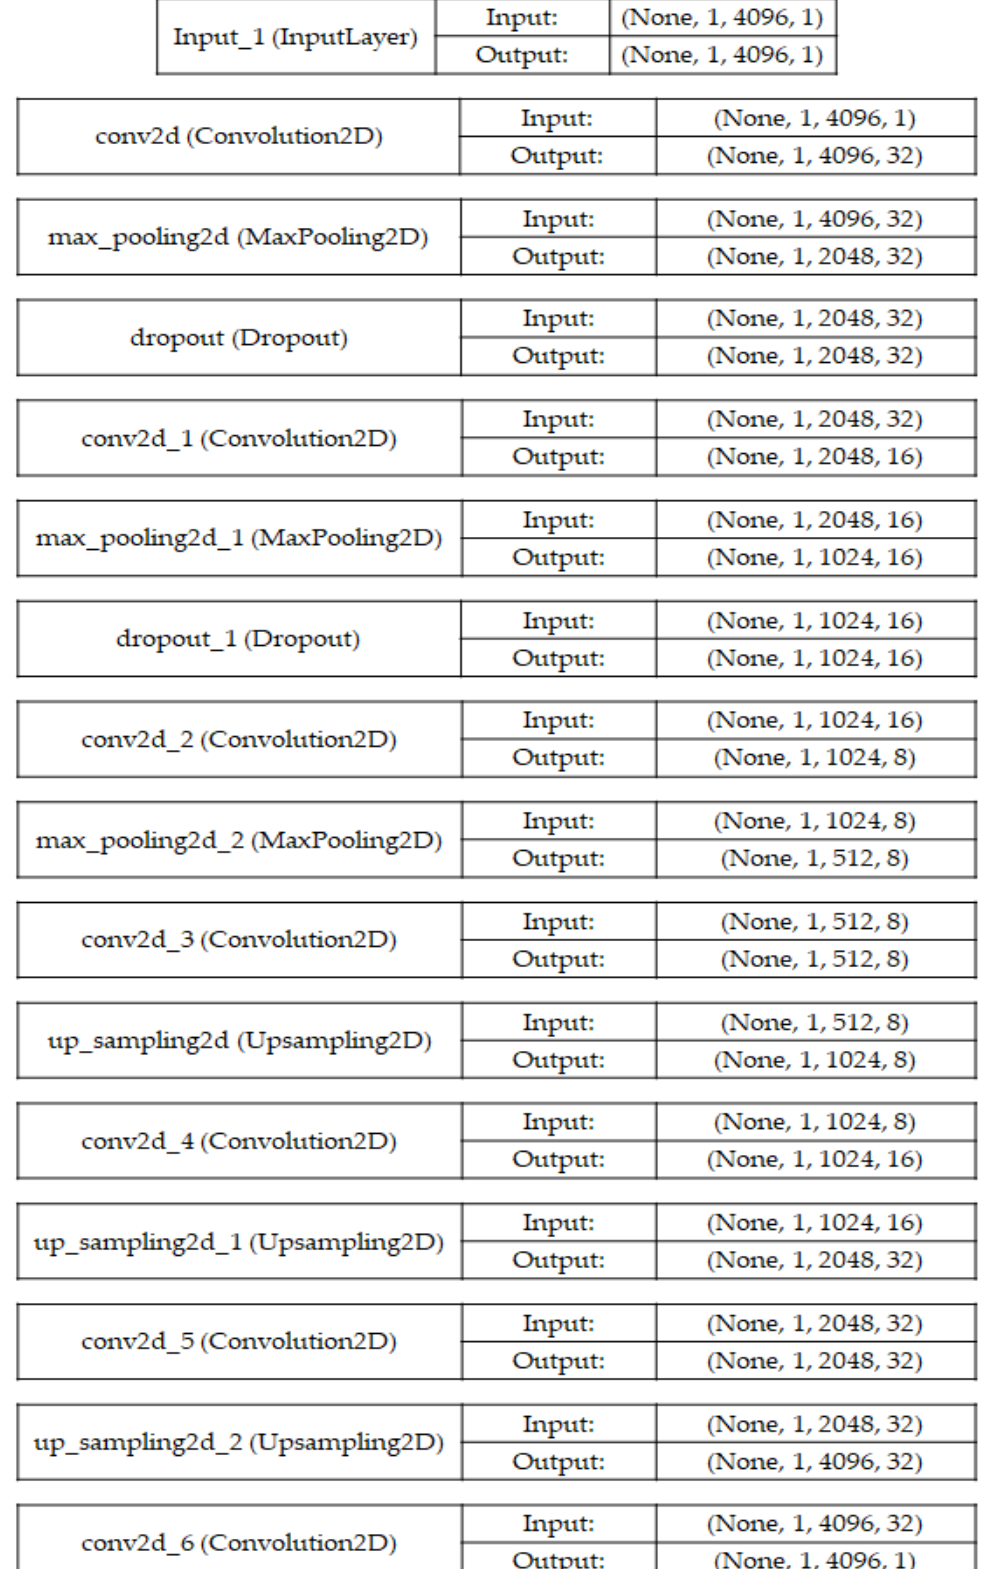
Figure 9. The architecture of DAE used in this study.